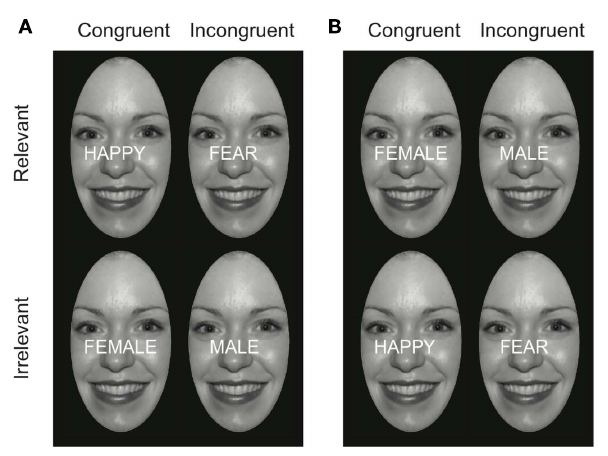
FIGURE 1 | Examples of experimental stimuli for (A) the emotion expression task and (B) the gender task. The experiment varied distracter congruency and relevance by manipulating the labels superimposed on the face stimuli.The labels were printed in red ink in the experiment, but have been presented in white ink here for display